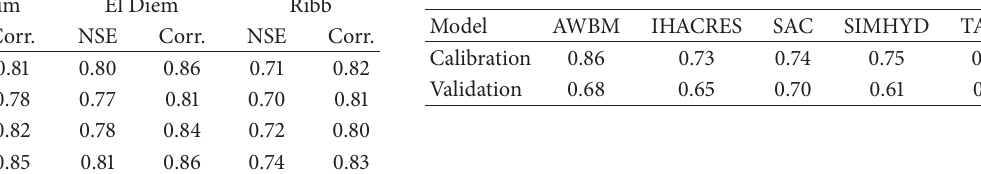
Table 3: Statistical measures of the agreement between the observed and simulated